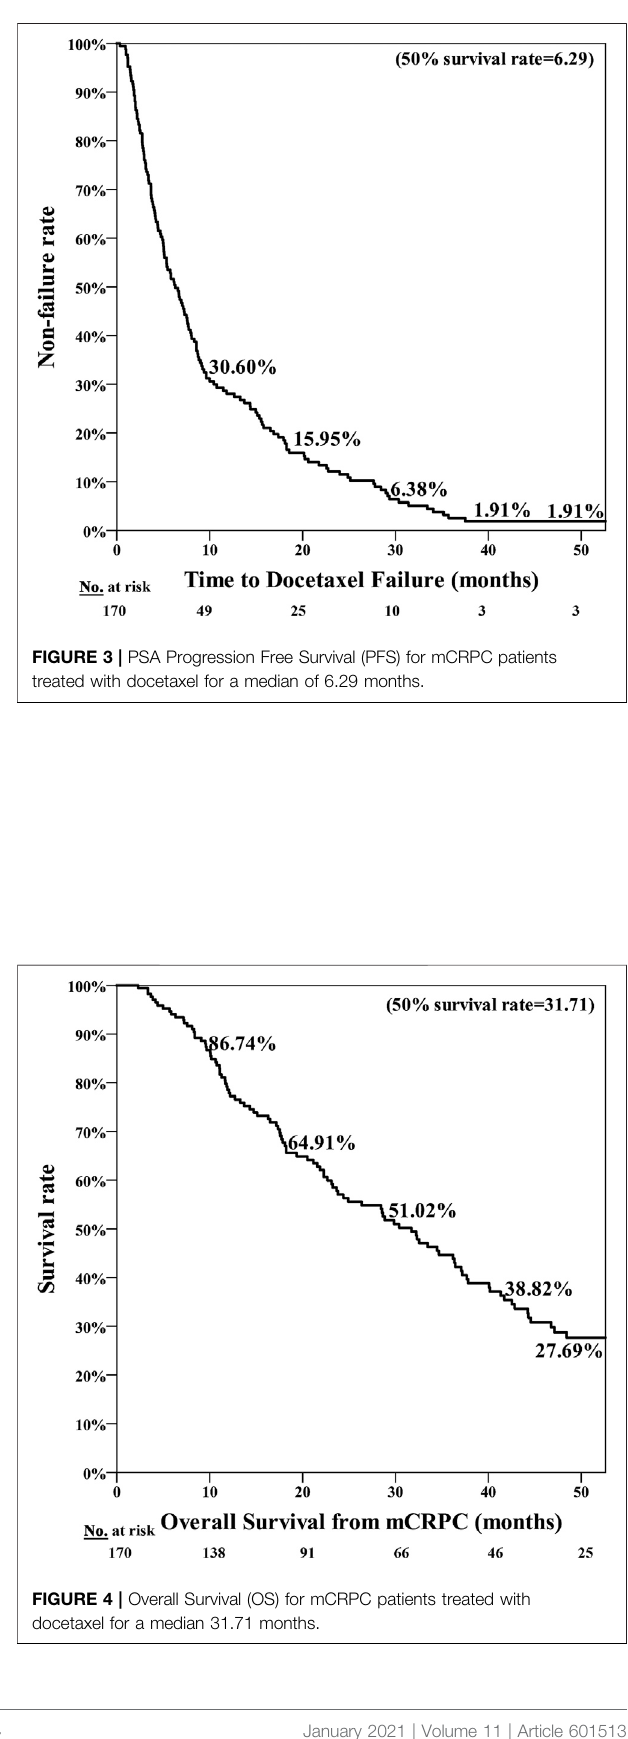
Frontiers in Pharmacology |